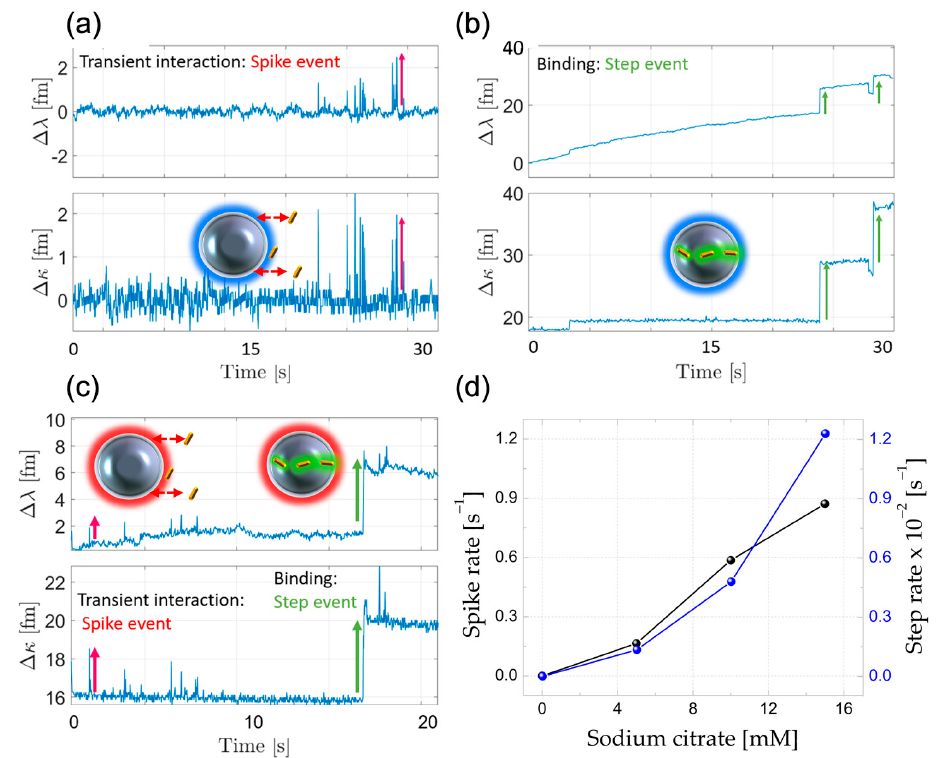
Figure 6. ( a ) WGM sensor traces for citrate-capped AuNR (pH 7, NaCl 10 mM, and 6 pM Au-NR), and ( b ) for 6 pM Au-NR@HS-Si(OH) n . ( c ) Both spikes (red arrows) and steps (green arrows) are observed for citrate-capped NR at buffer with pH = 3 and 2 pM Au-NR@HS-Si(OH) n . ( d ) Spike and step rate dependences on the concentration of citrate buffer at pH = 3.